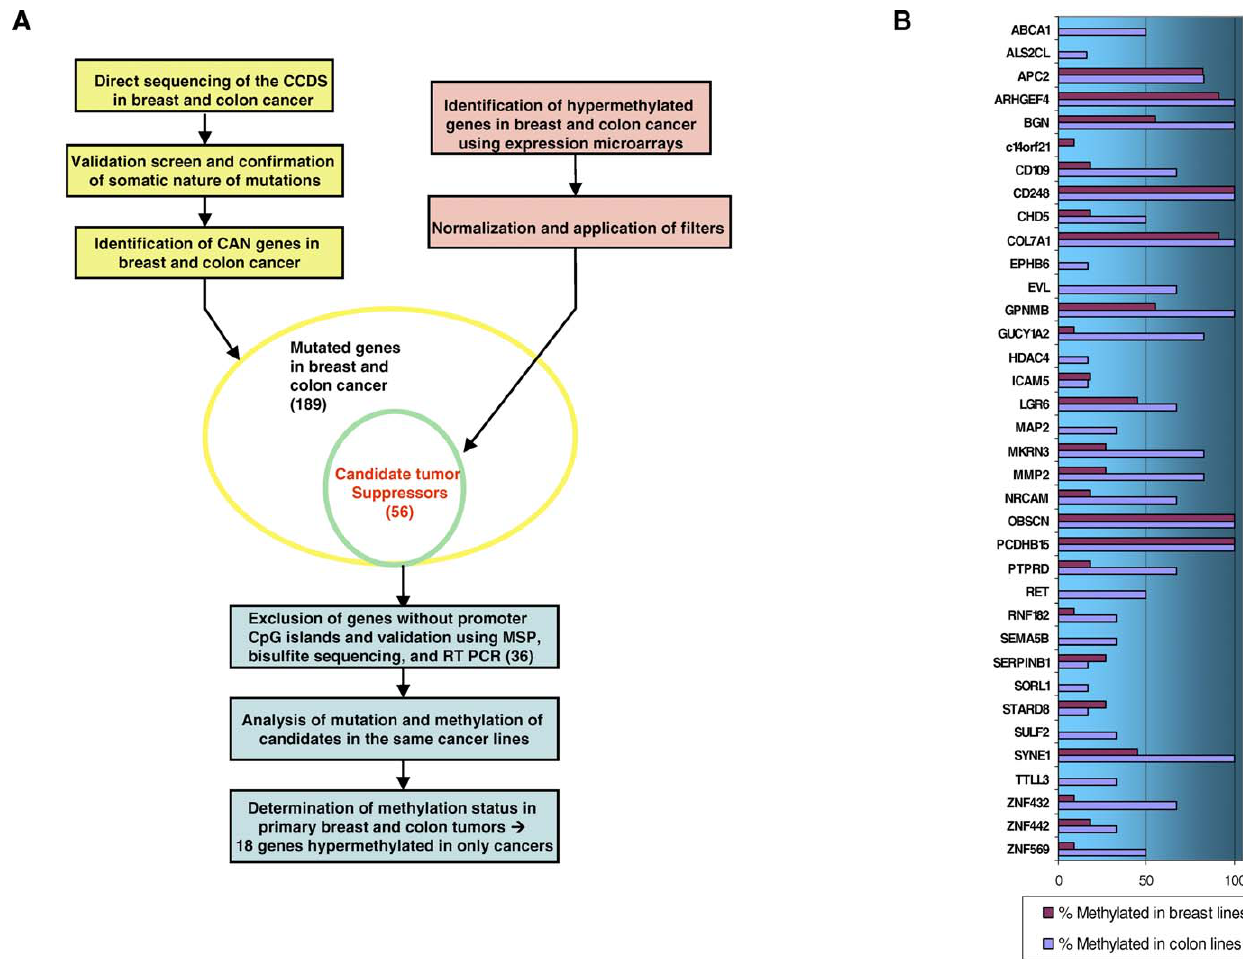
Figure 1. Strategy to Identify Common Gene Targets of Mutation and Promoter Hypermethylation in Cancer (A) Large-scale sequencing of breast and colon cancers identified 189 CAN genes as reported by Sjoblom et al. [7]. Candidate hypermethylated genes were identified via expression microarray analysis as described in the text. The cell lines used in the analyses were the breast cancer lines MCF7, MDA- MB-231, MDA-MB-468, and T-47D; and the colon cancer lines SW480, RKO, HCT116, Caco-2, Colo320, and HT-29. Filters were used as discussed in the text. Genes without promoter CpG islands were excluded. (B) Frequency of promoter methylation in the 36 CAN genes that are subject to hypermethylation. x -Axis denotes percent methylation. Methylation status was determined in the six colorectal cancer cell lines and in the 15 breast cancer lines described in the text (four lines used for microarray analysis plus 11 ‘‘ Discovery Phase ’’ breast cancer lines).